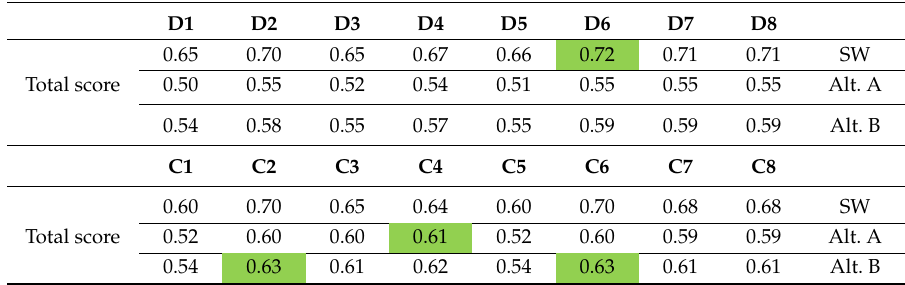
Table 11. Overview to the ranking results of all three weighting schemes. The total score and resulting rank are illustrated for each weighting scheme and scenario. The top scores are highlighted in green